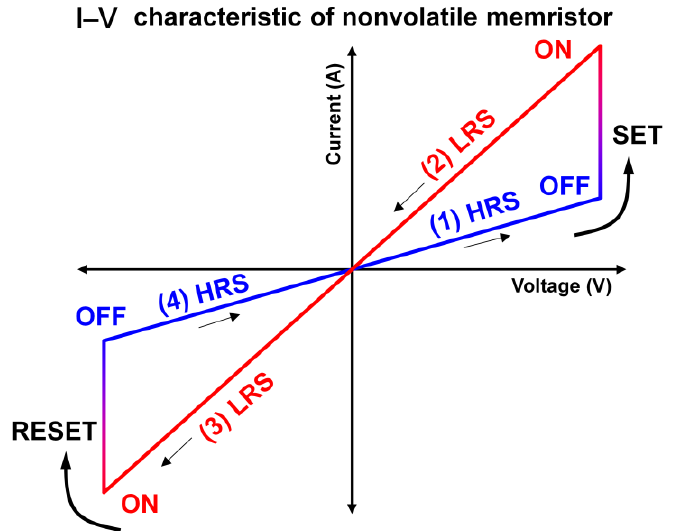
Figure 1. Typical I – V curve of a nonvolatile memristor under bipolar voltage sweep. The SET process occurs above a certain voltage threshold, and the resistance state changes from high-resistance state (HRS) to low-resistance state (LRS), thereby causing an abrupt increase in current (1). In (2), the device maintains the LRS; thus, the current value is considerably higher. During the negative voltage sweep, the device still retains the LRS (3); however, certain negative voltages lead to the RESET process, returning the LRS to the HRS (4).